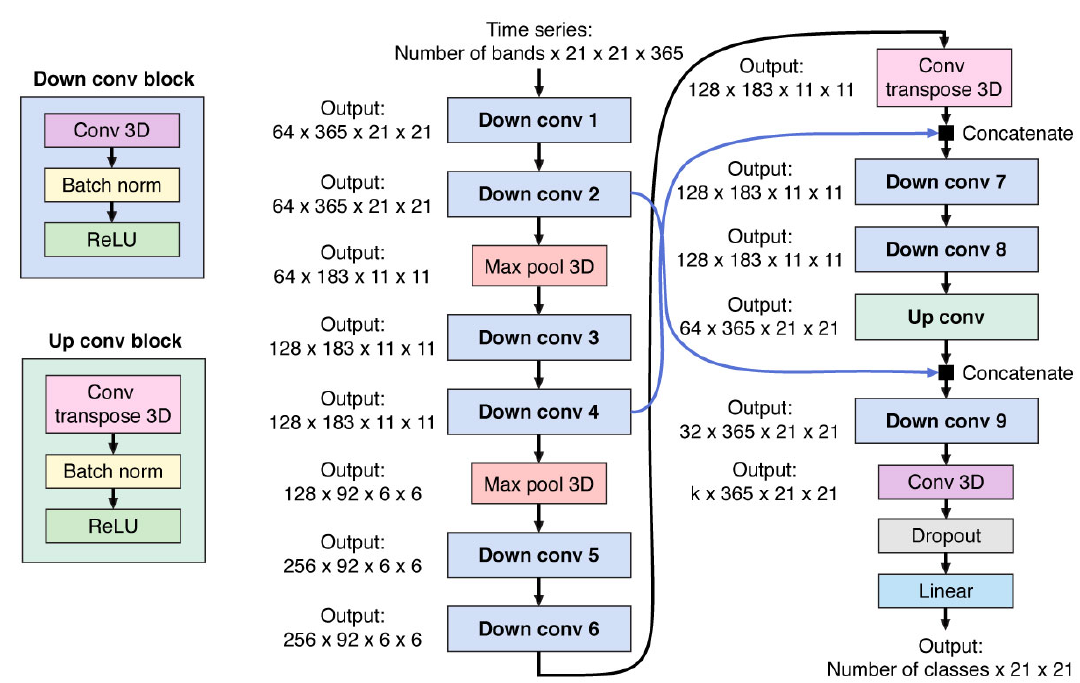
Figure A16. 3D CNN